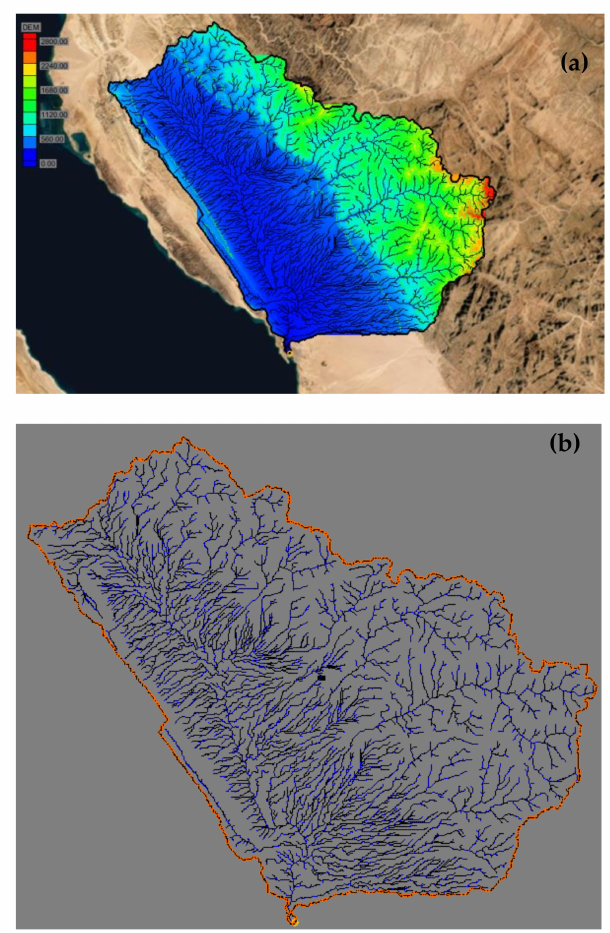
Figure 3. Study area ( a ) digital elevation model and ( b ) watershed characteristics in the study